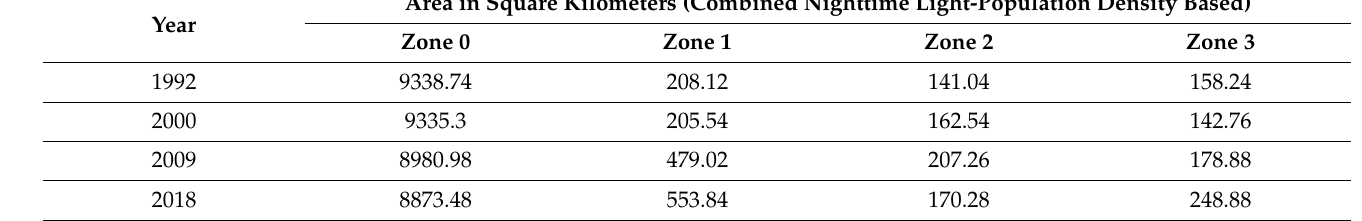
Table 9. Area Calculation for the Representative Years When Combined Criteria are Considered.